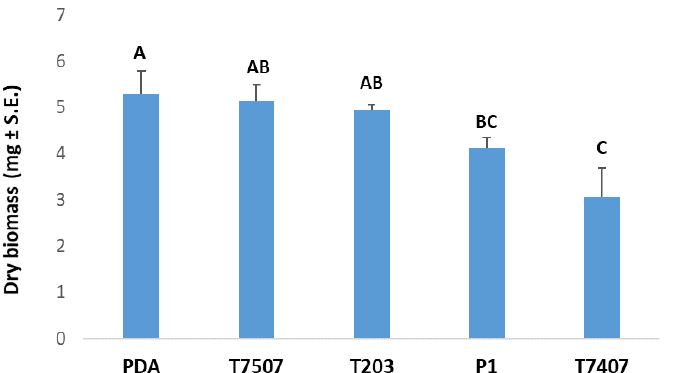
Figure 1. Effect of the growth fluid metabolites of Trichoderma isolates on the development of M. maydis submerged cultures. The Trichoderma isolates are T. asperelloides (T203), T. longibrachiatum (T7407, T7507), and T. asperellum (P1). All colonies were grown for six days. Control is potato dextrose broth (PDB) medium M. maydis cultures, maintained under the same conditions. The M. maydis dry weight was measured at the experiment’s end. Error lines represent a standard error of five repetitions. Statistical significance ( p < 0.05) of variance was tested using the one-way ANOVA test and is represented by different letters (A–C) above the chart bars.